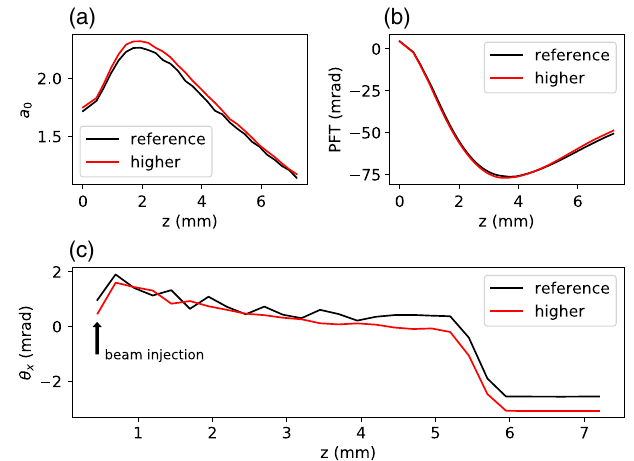
FIG. 5. Evolution of laser pulse and electron beam parameters during propagation for two simulations with the same physical parameters, with the reference resolution (transverse and longi- tudinal cell sizes are 0 . 833 μ m and 26.0 nm, respectively, in black) and a higher resolution (transverse and longitudinal cell sizes are 0 . 625 μ m and 19.5 nm, respectively, in red). (a) Laser normalized amplitude a 0 ; (b) laser pulse front tilt angle; (c) electron beam propagationdirection θ x